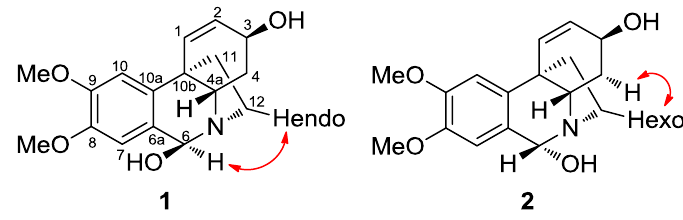
Figure 3. Key NOESY correlations of compounds 1 and 2 .